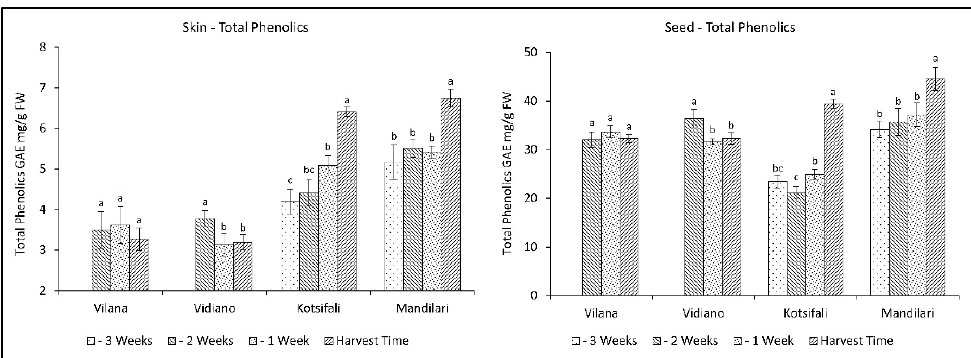
Figure 2. Skin and seeds total phenolics of Vilana, Vidiano, Kotsifali and Mandilari cultivars during ripening. The error bars represent the standard errors of the means. Different letters indicate statistically significant differences among weeks, according to Duncan’s multiple range test ( p ≤ 0.05).